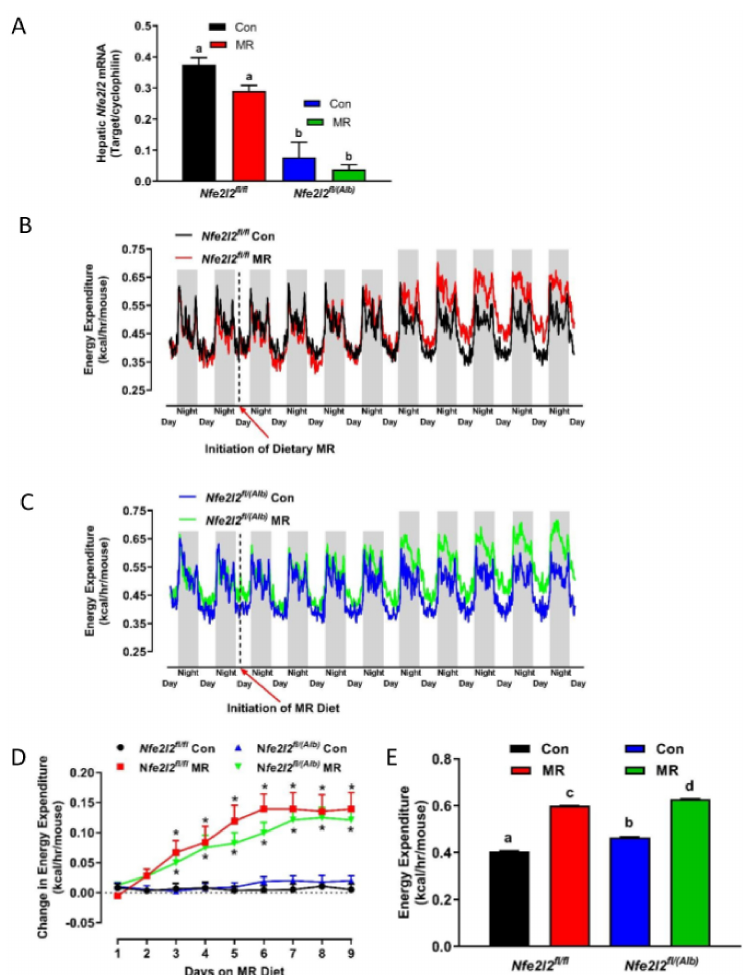
Figure 1. Hepatic Nfe2l2 mRNA ( A ), initial changes in energy expenditure (EE) after introduction of dietary MR ( B – D ), and change in 24 h EE at the end of the experiment ( E ) in Nfe2l2 fl/fl (WT) and Nfe2l2 fl/(Alb) ( NRF2 KO) mice fed Con or MR diets. Primers designed to detect excised sequences in exon 5 of the Nfe2l2 gene were used to detect Nfe2l2 mRNA in livers from mice of the two genotypes by real time qPCR ( A ). EE was measured and analyzed during the run-in period and at the end of the experiment by ANCOVA as described in the Materials and Methods ( B – E ). In ( D ), the initial diet-dependent change in nighttime EE was calculated by subtracting the nighttime EE of each group prior to introduction of MR from the nighttime measures of EE during the 9 days after initial exposure to the MR diet on day 0. Means are representative of data from 7 or 8 mice per group and compared by two-way ANOVA as described in the Materials and Methods. Means annotated with a different letter differ at p <